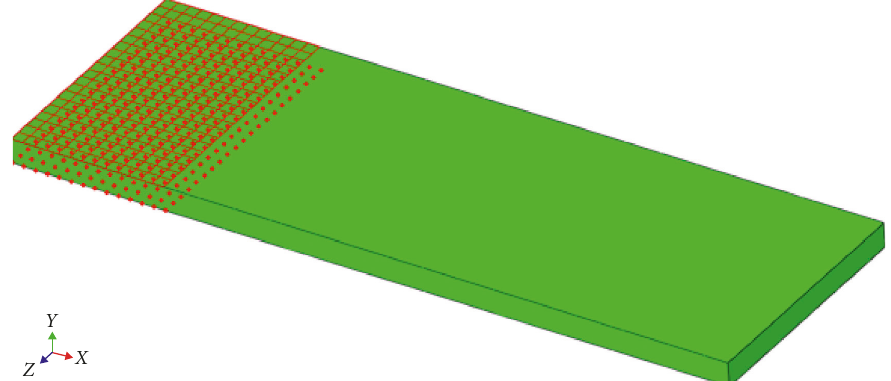
Figure 2: Electric load application to the electrode tape, which takes into account the circularity of the electrocontact